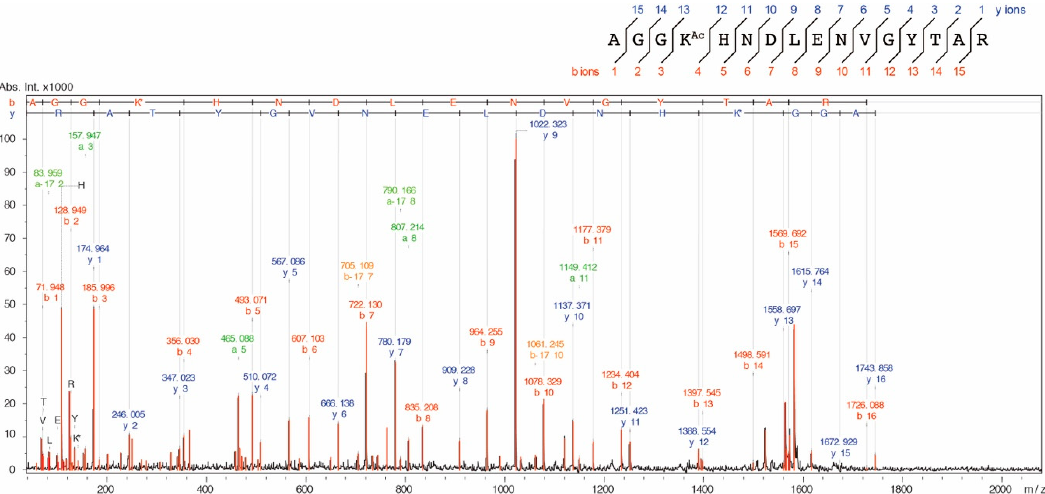
Figure A2. MS/MS ion spectrum of the K73Ac-acetylated peptide (71-AGGK Ac HNDLENVGYTAR-86, m/z 1743.839). AlaRS K73Ac ( ∆ CobB) was reduced with 20 mM dithiothreitol (DTT) and subsequently alkylated with 30 mM iodoacetamide and digested with a sequence-grade trypsin (Promega). The proteolytic peptides were cleaned using a ZipTip C18 column (Merck Millipore) and analyzed by an autoflex speed TOF/TOF mass spectrometer (Bruker, Billerica, MA, USA).